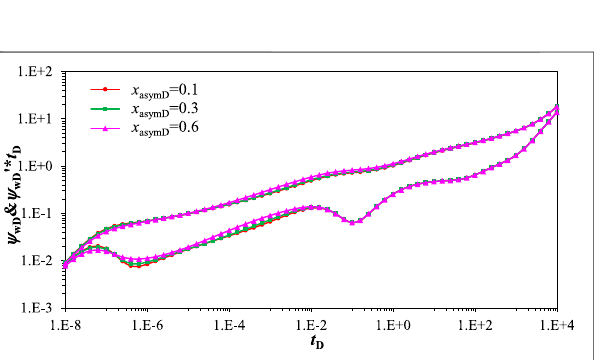
FIGURE11| Ratedistributioncurveeffectedbyasymmetryfactor.( C D = 1e-5, S =0.01, L F =150 m, θ F =90 o , C FD =10, R e =3000 m, r o =2000 m, ω = 0.1, λ = 1, σ = 0.7, β m =